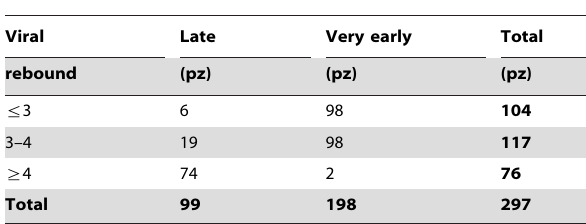
Contingency table for simulated data where the expected frequency count for each cell of the table is at least 5. The rows represent the average viremia after 4 weeks from treatment interruption in logarithmic scale. The columns represent the two groups in which HAART starts during chronic phase ( late ) or within the